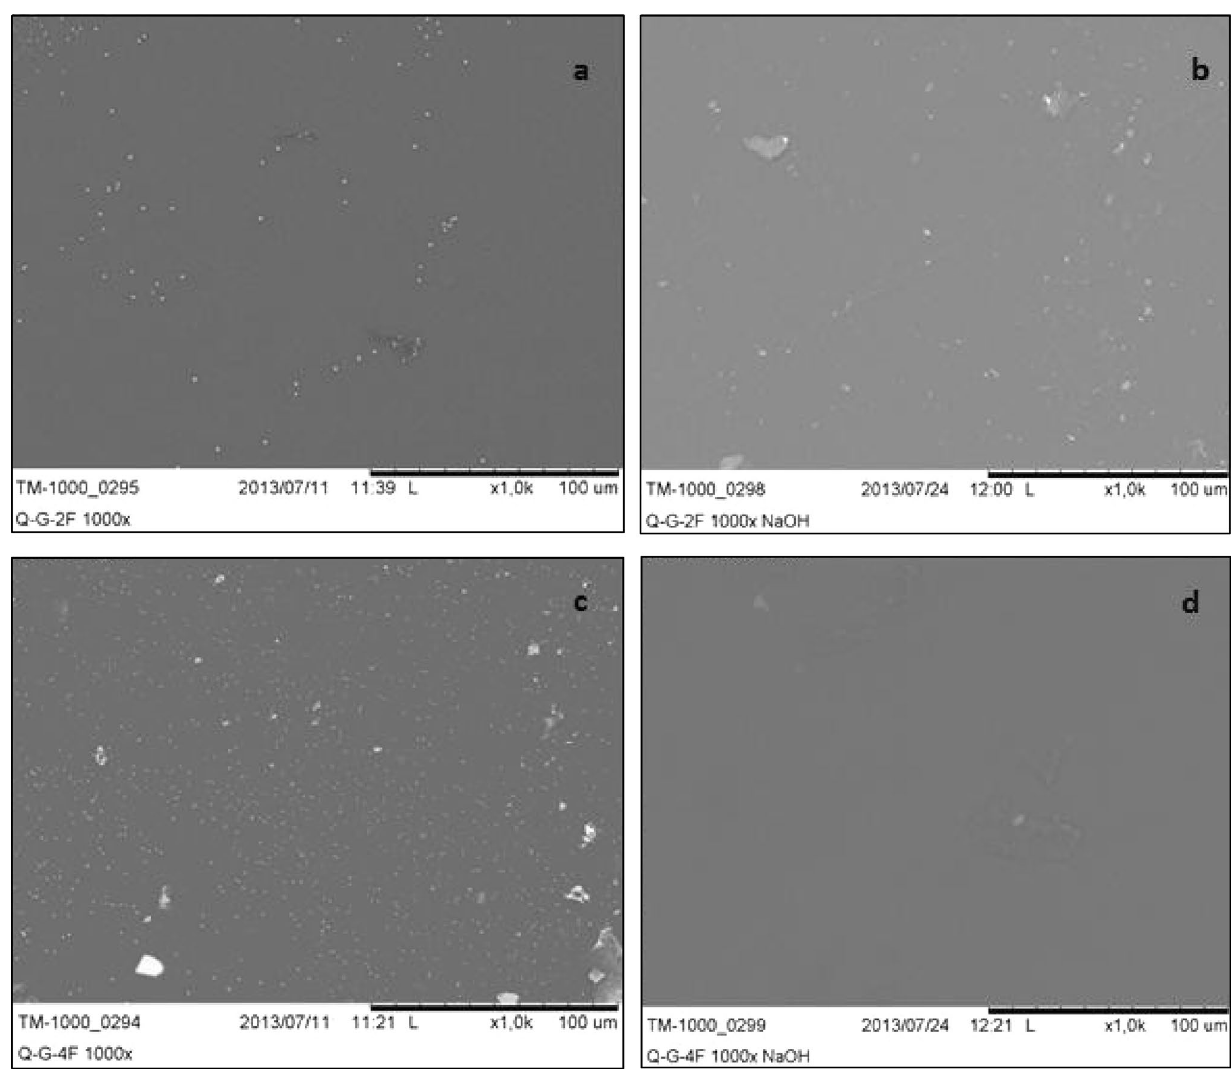
tosan with gelatin with 40 mg heparin (Q/G/4H); and d Chitosan with gelatin with 40 mg heparin